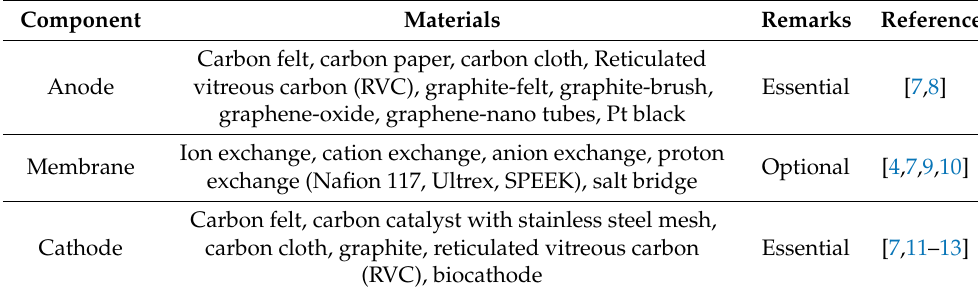
Table 1. Major three components of microbial fuel cell and material